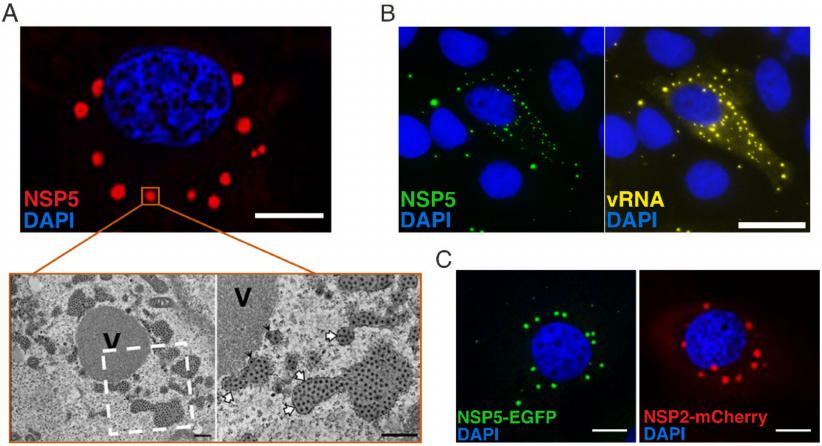
Figure 2. Rotavirus viroplasm formation. ( A ) Formation of rotavirus viroplasm. Upper panel: Immunofluorescent image of a rotavirus-infected cell at 10 hpi, stained with anti-NSP5 antibody (red) and DAPI (blue). Scale bar, 10 µ m. Lower panel: Electron micrographs of MA104 cells infected with wildtype (WT) rotavirus (MOI, 75 FFU/cell) at 10 hpi. V, viroplasm. The white open box denotes an area shown at higher magnification in the right-hand EM photograph. White arrows indicate endoplasmic membranes surrounding viroplasms; black arrowheads indicate viral particles with an envelope. Scale bar, 500 nm. Adapted with permission from Papa et al. [25]; ( B ) Confocal imaging of rotavirus transcripts via fluorescence in situ hybridisation (FISH). FISH probes specific to the rotavirus transcripts (segment 1–11) were used to visualise RV transcripts in EGFP-NSP5-tagged viroplasms (green). RNA signal is shown in yellow (Quasar 560-labelled probes). Nuclei were stained with DAPI (blue), Scale bar, 10 µ m. Adapted from Strauss et al. [26]; ( C ) Rotavirus infection of cells constitutively expressing fluorescently labelled NSP2 and NSP5 proteins. Recruitment of NSP5-EGFP in green (left) or NSP2-mCherry in red (right) proteins to viroplasms in rotavirus-infected MA104 cells constitutively expressing the two fluorescent fusion proteins. DAPI (blue) detects nuclei. Scale bar: 10 µ m. From Papa